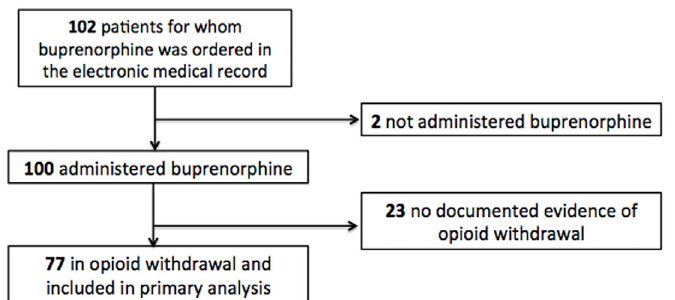
Figure 2. Flowchart for patients included in primary analysis of patients for whom buprenorphine was ordered in the emergency department for opioid